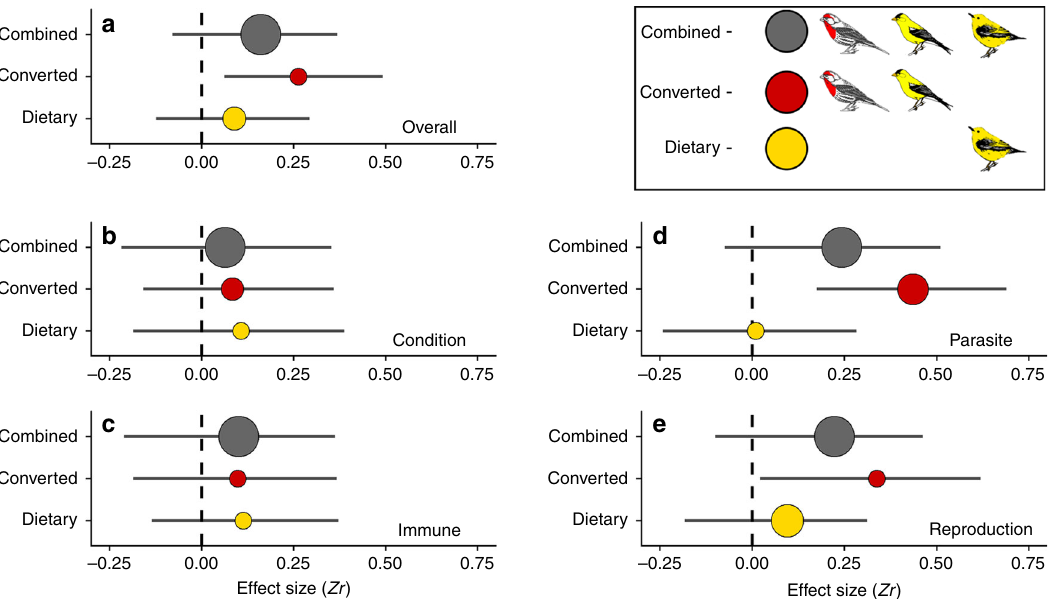
Fig. 2 Results of the multilevel phylogenetic meta-analyses. The weighted mean correlation (Zr) betwen feather color richness and measures of individual quality. a The strength of the association was calculated for all published studies without consideration of the carotenoid type in the feathers of the study bird (Combined, gray circles, number of effect sizes ( n ) = 191), for only studies of bird species with plumage coloration derived from converted carotenoids (red circles, n = 92), and for only studies of bird species with plumage coloration derived from dietary carotenoids (yellow circles, n = 99). Proxies of quality were divided into ( b ), body condition (overall: n = 35, converted: n = 18, dietary: n = 17), ( c ) immune and oxidative physiology (overall: n = 42, converted: n = 21, dietary: n = 21), ( d ) parasite resistance (overall: n = 49, converted: n = 30, dietary: n = 19), and ( e ) aspects of parental and reproductive quality (overall: n = 65, converted: n = 23, dietary: n = 42). Circle size is inversely proportional to the variance of the mean effect size. Horizontal lines